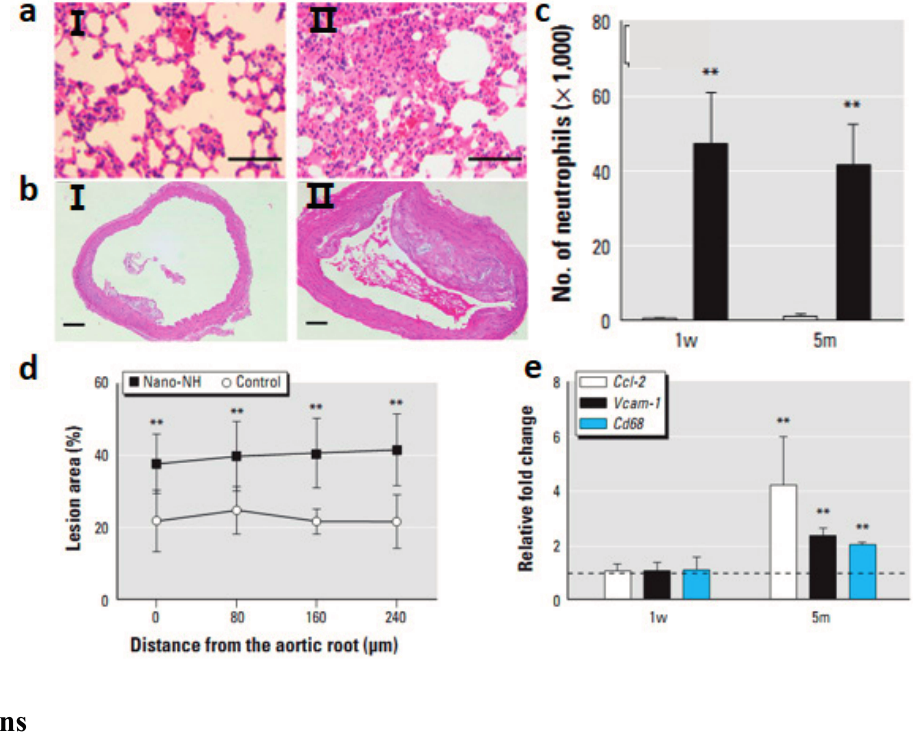
Figure 4. ( a ) HE-stained images from a control mouse (I) and a nano-NH-exposed mouse (II); bars = 0.1 mm [65]; ( b ) Photomicrographs of HE-stained aortic cross-sections from control (I) and nano-NH (II) mice in the 5m (5 month) group; bars = 0.2 mm [65]; ( c ) Number of neutrophils measured in BALF in mice after 1 w or 5m nano-NH exposure (79 μ g Ni/m 3 nano-NH). All markers were measured 24 h after the last exposure; values are mean ± SD ( n = 6/group). ** p < 0.01 compared with control [65]; ( d ) Relative plaque area at four different locations of the ascending aorta (at 80 μ m intervals) in the 5m group; values are expressed as mean ± SD ( n = 7/group). ** p < 0.01 compared with control [65]; ( e ) Relative mRNA levels of Ccl-2, Vcam-1, and Cd68 in aortas from the 1 w (1 week) and 5 m (5 months) exposure groups; values are mean ± SD ( n = 6/group) expressed as relative fold increase over controls (normalized to 1; dashed line). All samples were collected 24 h after the last exposure. ** p < 0.01 compared with control